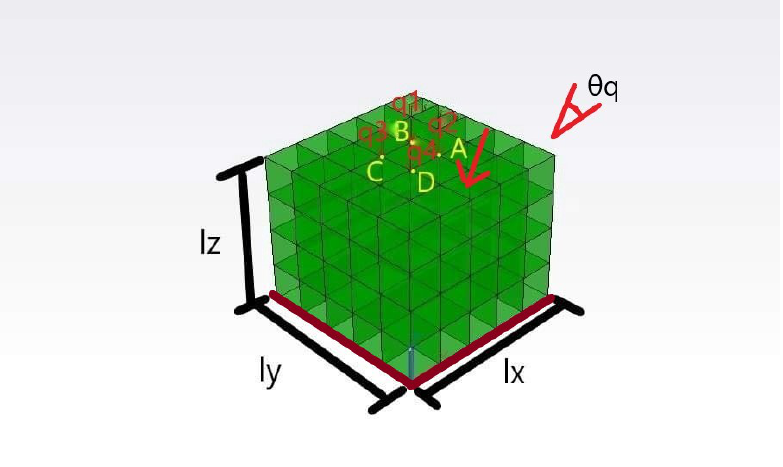
Figure 3. The soil domain and the loads applied for oblique loading, where l x = 5 m , l y = 5 m , l z = 4 m and q 1 = max ( q 1 , q 2 , q 3 , q 4 ) , q 2 = min ( q 1 , q 2 , q 3 , q 4 ) . The lines colored in maroon indicate the boundary conditions and the points considered as fixed u x ( z = h ) = u y ( z = h ) = u z ( z = h ) = 0 .